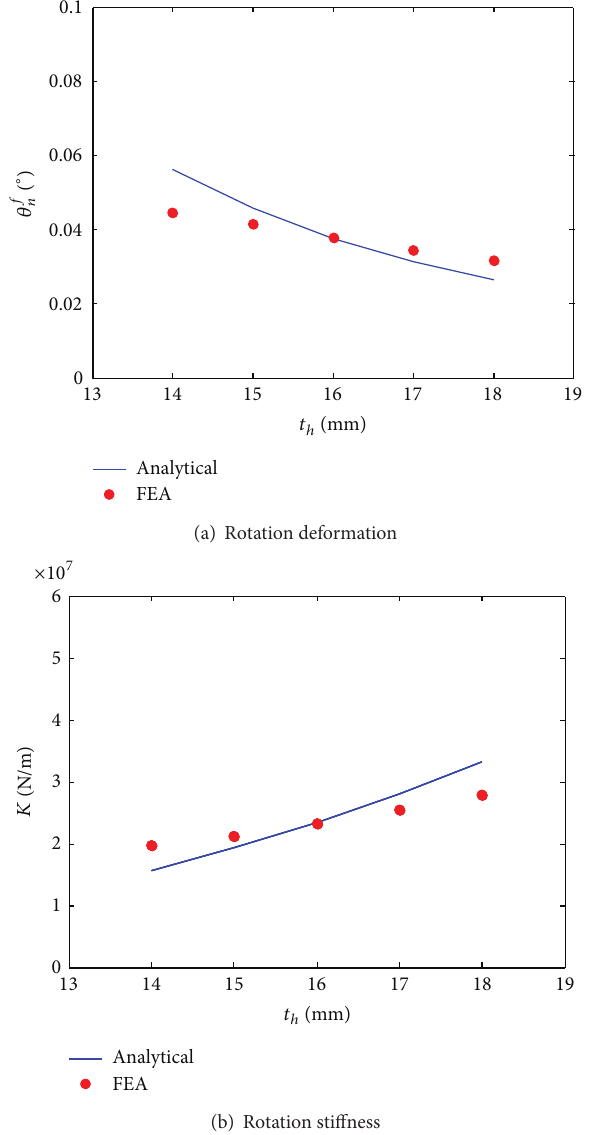
Figure 10: Rotation stiffness and deformation of nut flank under different locking force with variation of 𝑡 𝑛 .